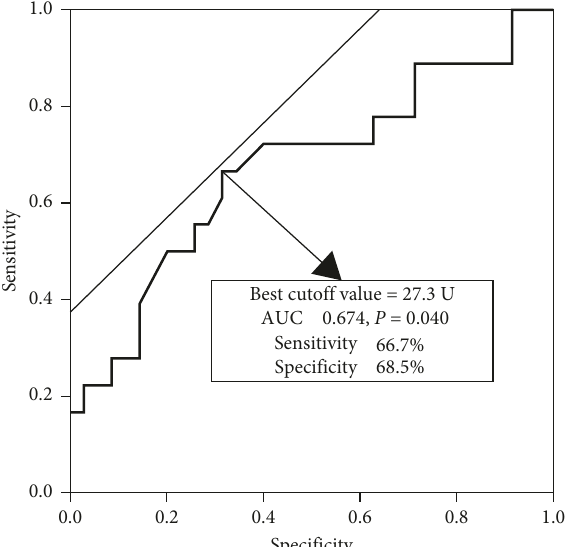
Figure 2: Receiver operator characteristic analysis to predict incomplete STR from the IMR value. The best cutoff value for IMR to predict incomplete STR was 27.3. AUC: area under the curve; IMR: index of microvascular resistance; STR: ST-segment elevation